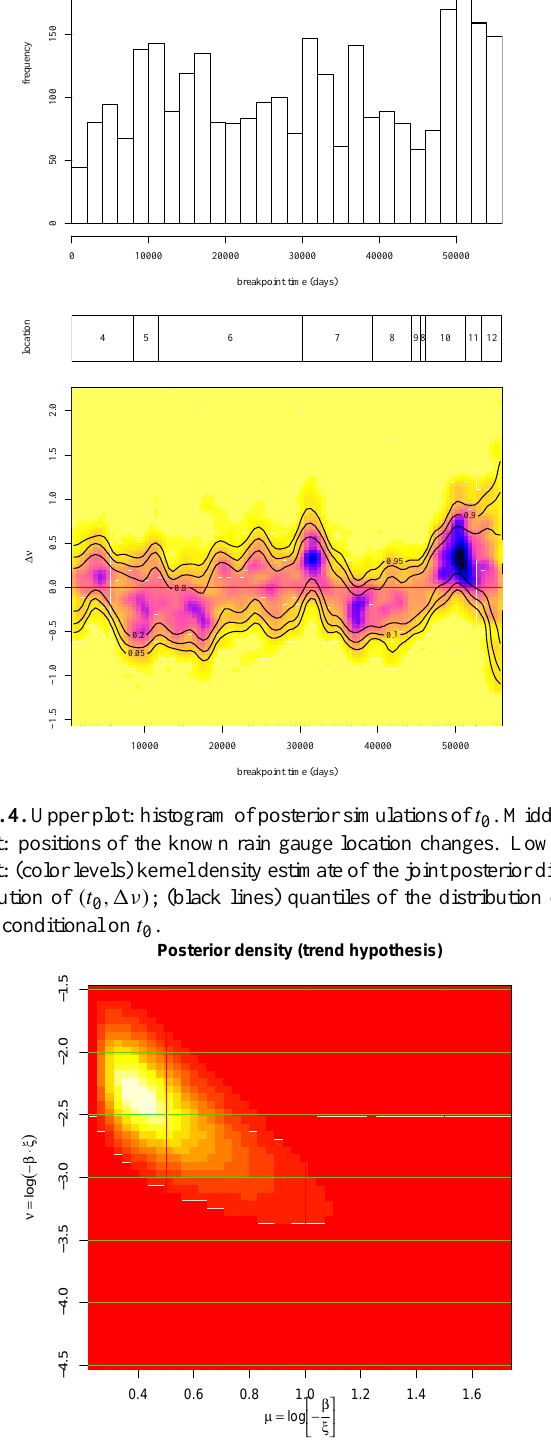
Fig. 5. Pixel map of posterior joint density for GPD parameters: new parameterization. Parameters µ and ν are non-dimensional.